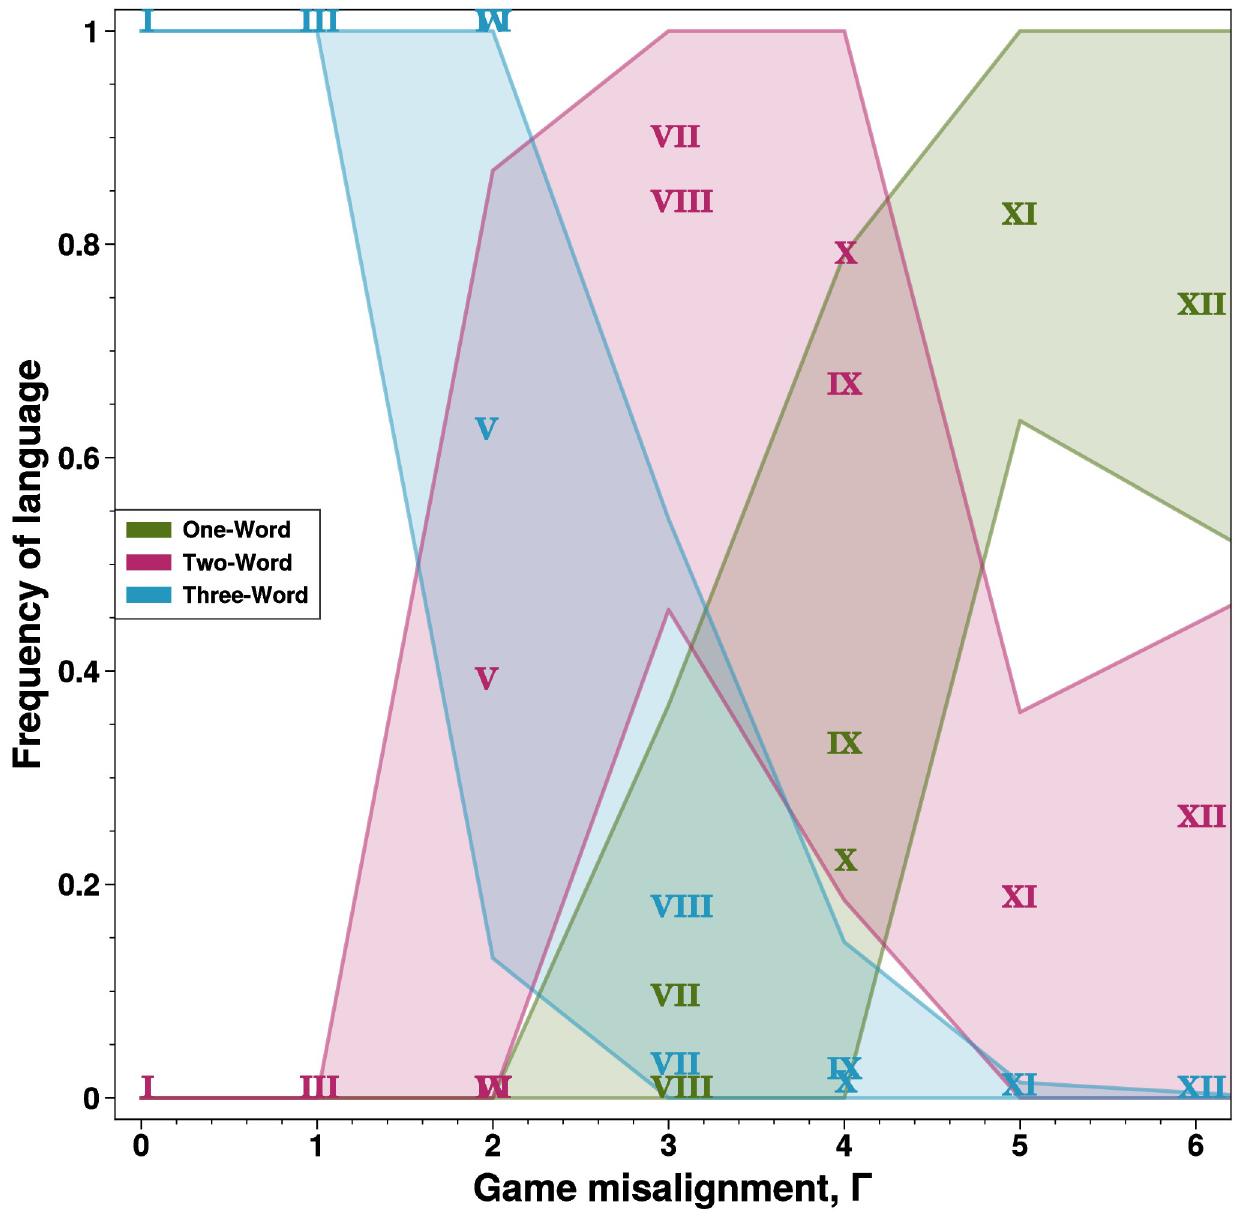
Fig 2. Misalignment of interests leads to loss of lexical breadth in a language. Here we show the average frequency of one-word and two-word languages in the asymmetric game(s) with k = 100 and μ = 0.001. A one-word language has two columns of P ij summing to 0 (two words never used), while summing to 0. Increasing misalignment leads to invasion by two-word languages and then by one-word a two-word language has one column of P ij languages. Roman numerals denote mean values, whereas ribbons denote one standard deviation above/below the mean. Nearly identical results hold for the symmetric case, see Fig E in S1 File. The overlapping game symbols for Γ = 1 are II,III , and for Γ = 2 are IV,VI